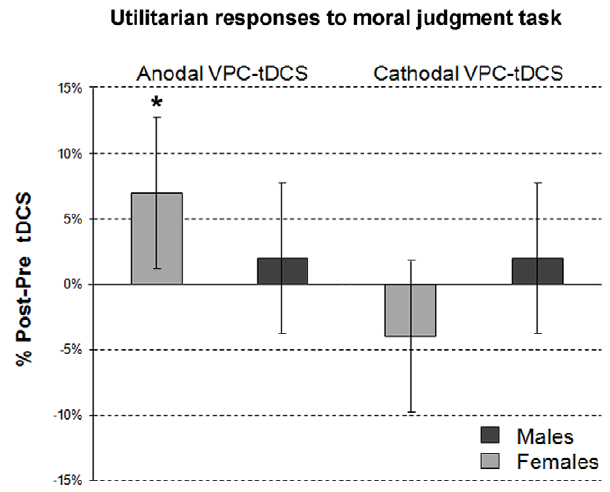
Figure 1. tDCS effects over the VPC on utilitarian responses to moral judgment task in males and females. Black columns: males. Gray columns: females. Y-axis: % (after-before) changes (0=baseline) of the occurrence of utilitarian responses after tDCS. *: Wald chi-square test=9.270; df=2; p=.010. Error bars are the 95% confidence intervals (2 standard error of the mean). Note that whereas in males after VPC- tDCS utilitarian responses remained statistically unchanged, in females, after anodal VPC-tDCS utilitarian responses significantly increased.